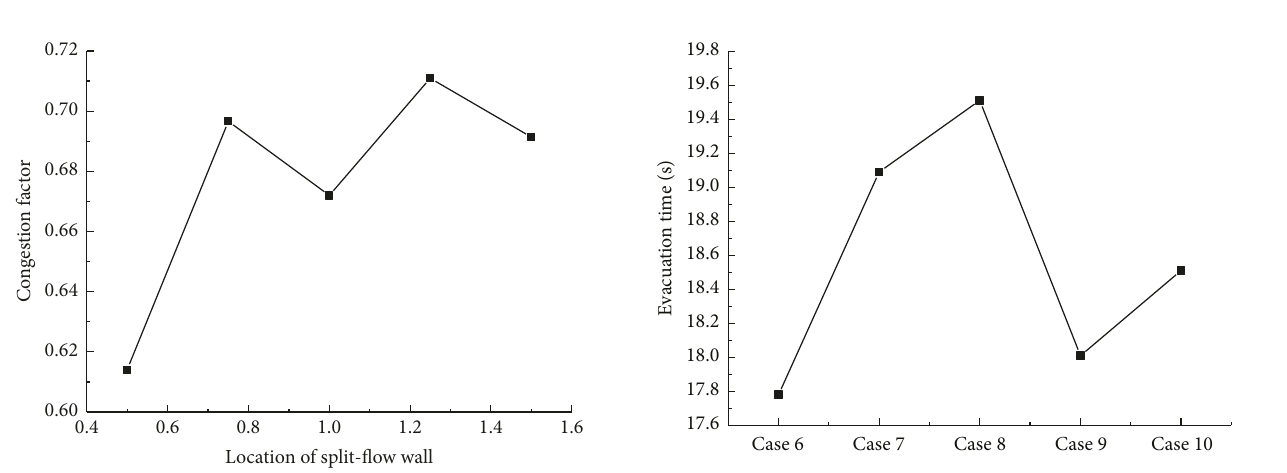
Figure 13: Congestion factor when 𝐿 = 2 , 𝜌 = 0.5 .